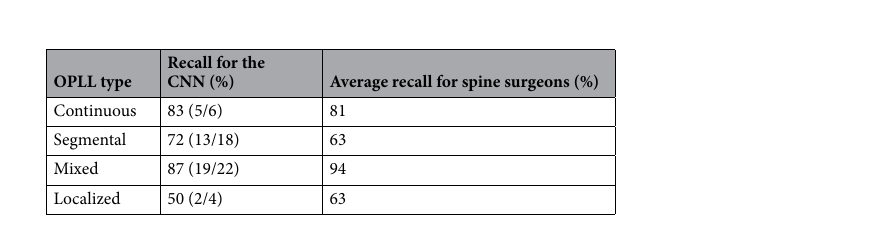
Table 4. The recall (sensitivity) of the CNN and spine surgeon for each OPLL